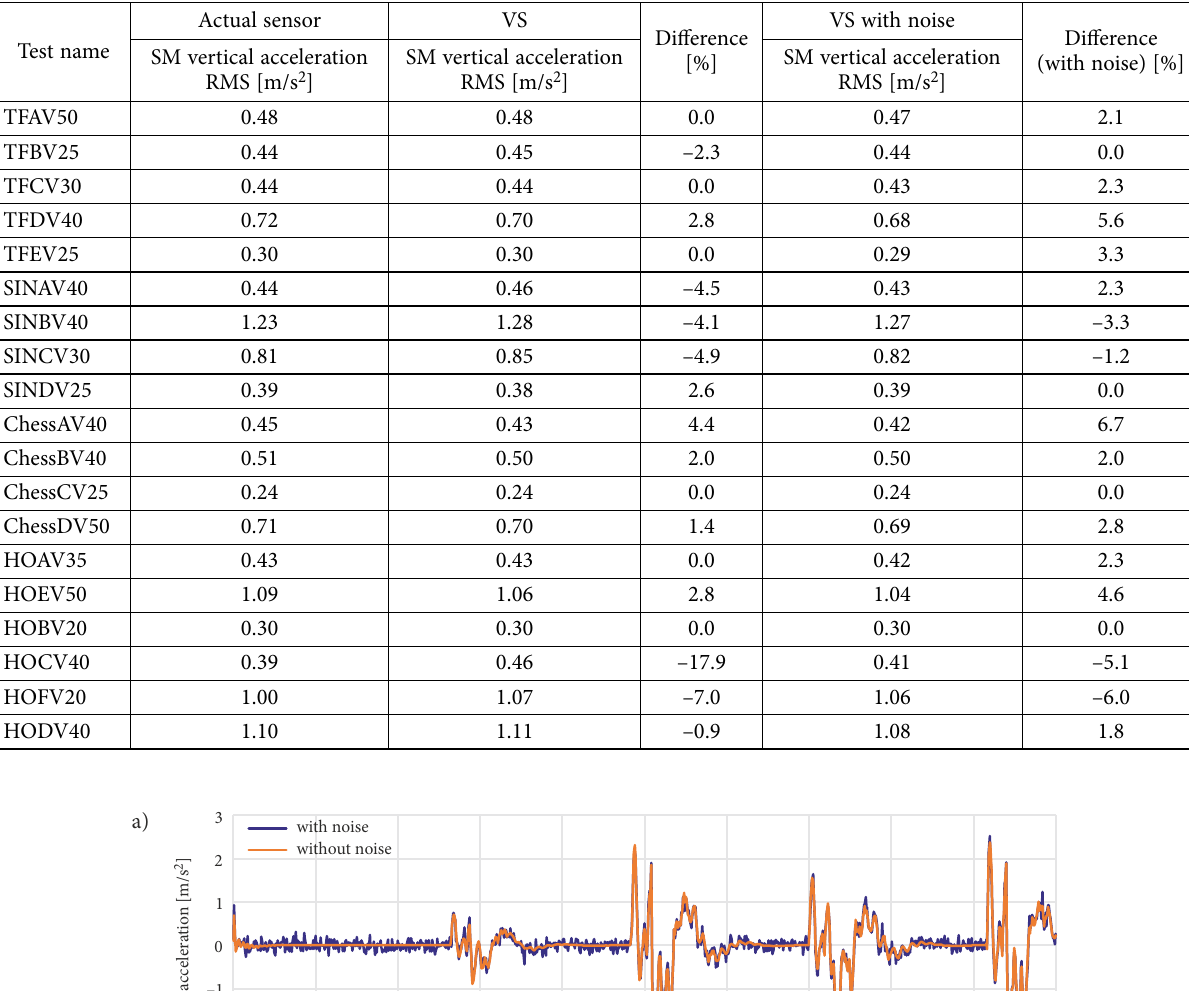
Table 4. RMS values of SM accelerations